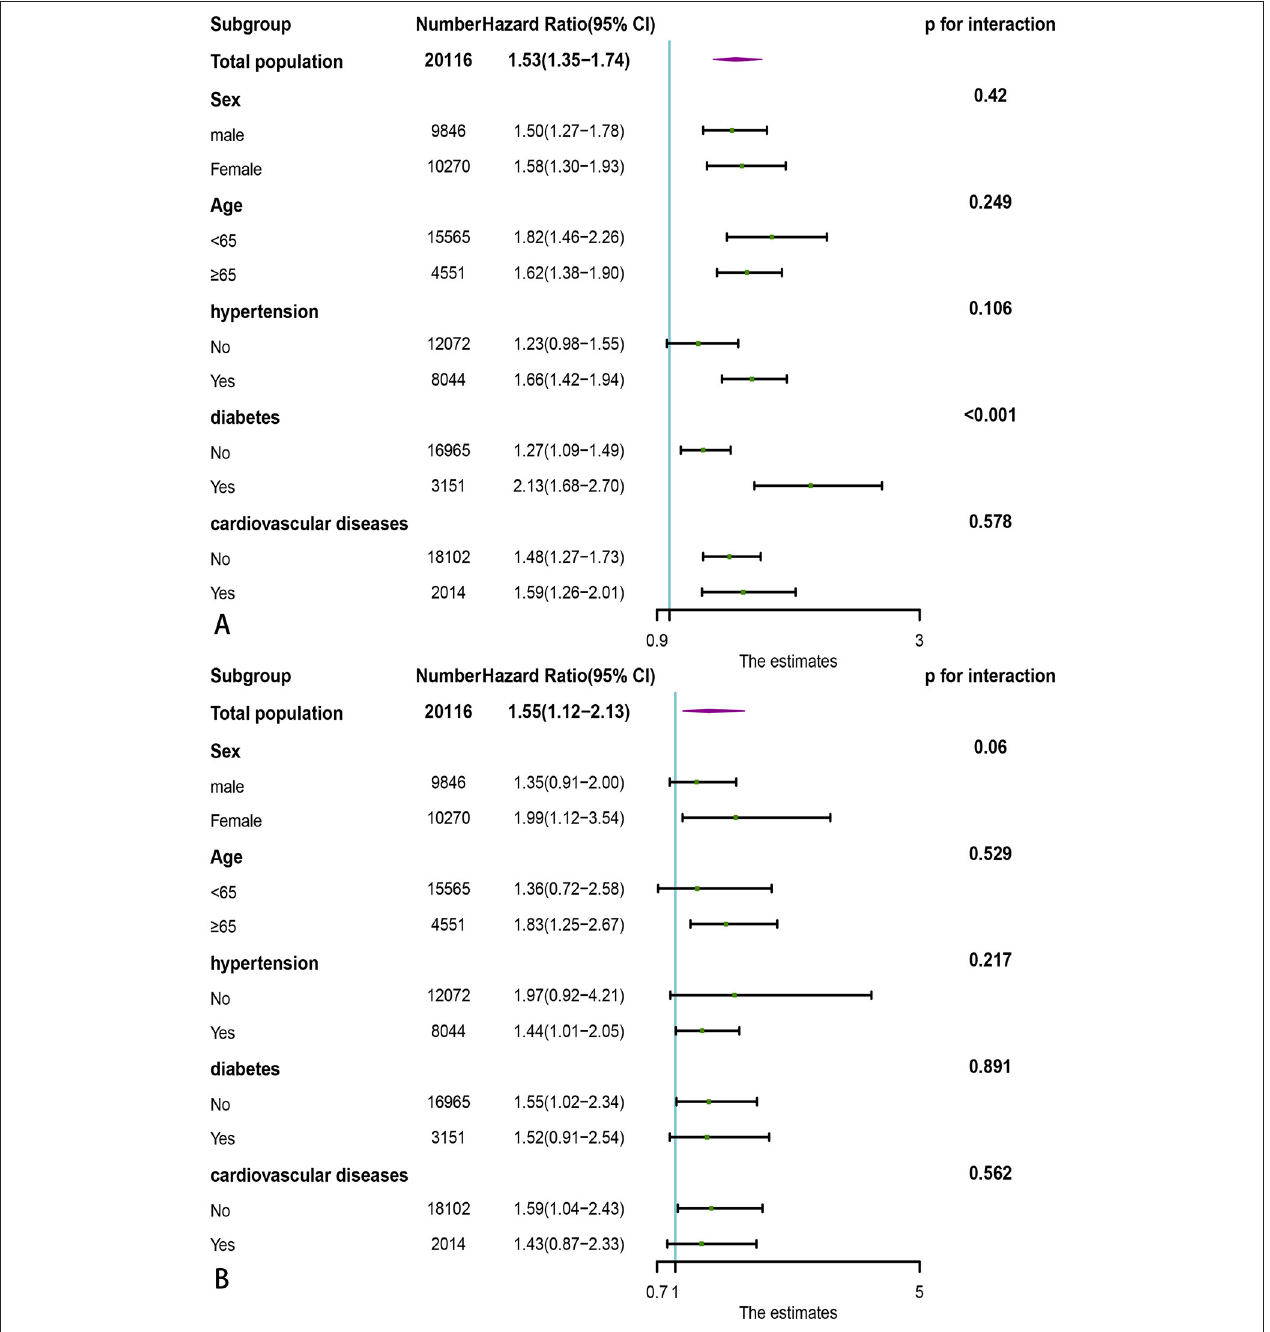
FIGURE 6 | Subgroup analysis of association of PNI with adverse outcomes in the general population. (A) All-cause death; (B) Cardiovascular death. PNI, Prognostic Nutritional Index.